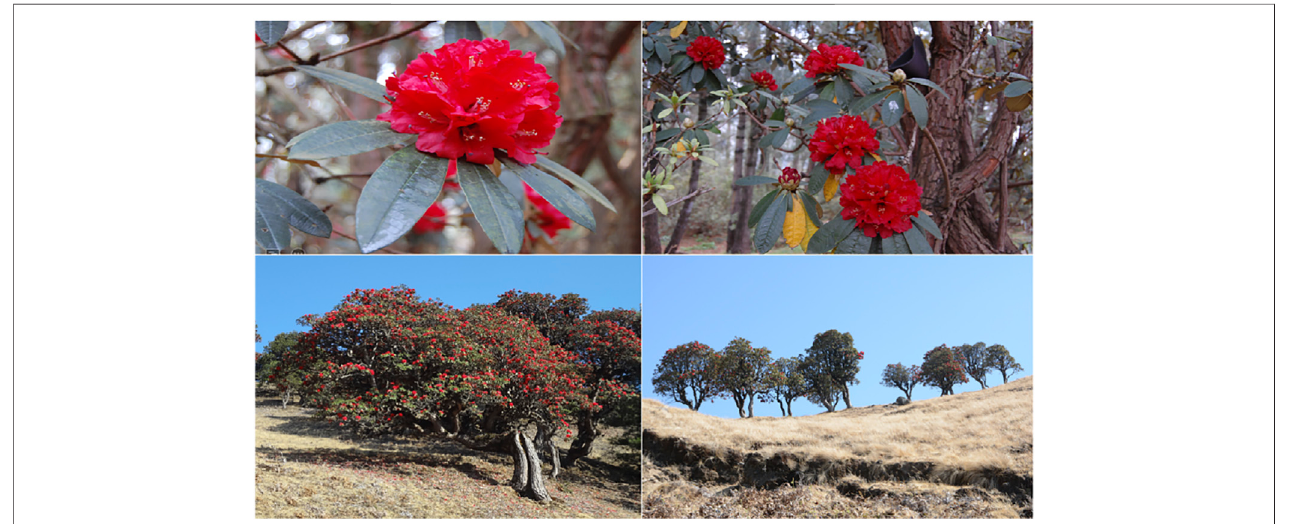
FIGURE 1 | Rhododendron delavayi in its natural habitat in Cangshan, Dali, Yunnan, China.